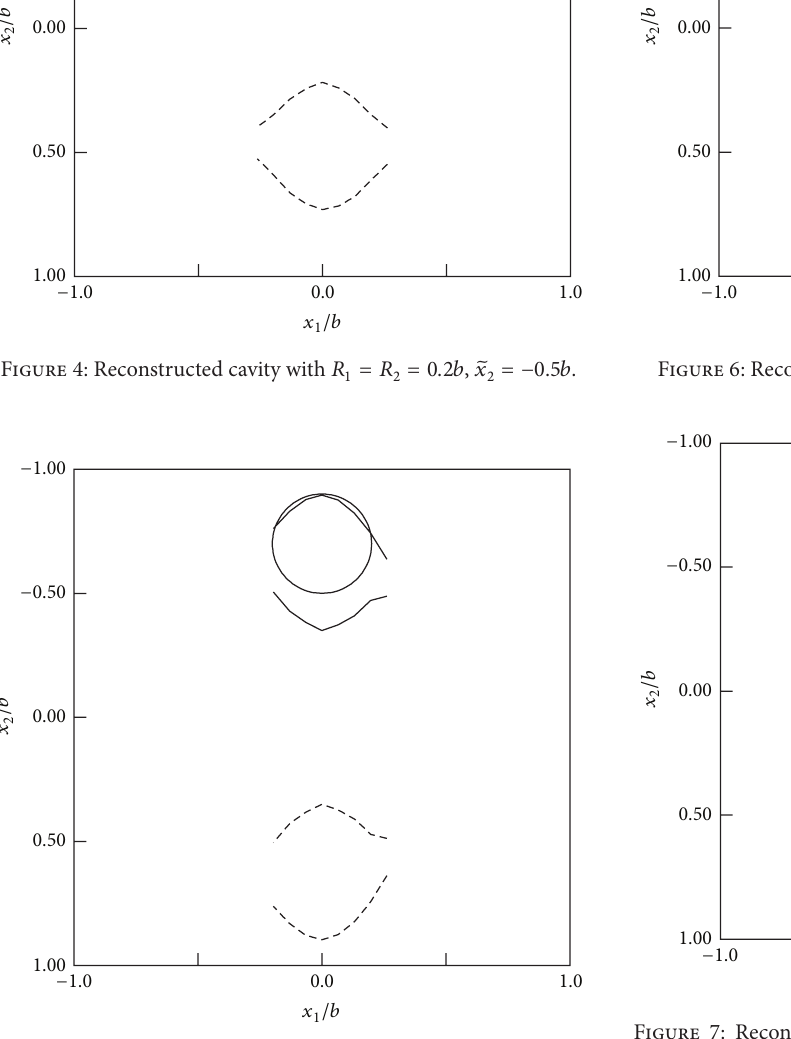
Figure 5: Reconstructed cavity with 𝑅 1 = 𝑅 2 = 0.2𝑏 , ̃𝑥 2 = −0.7𝑏 .